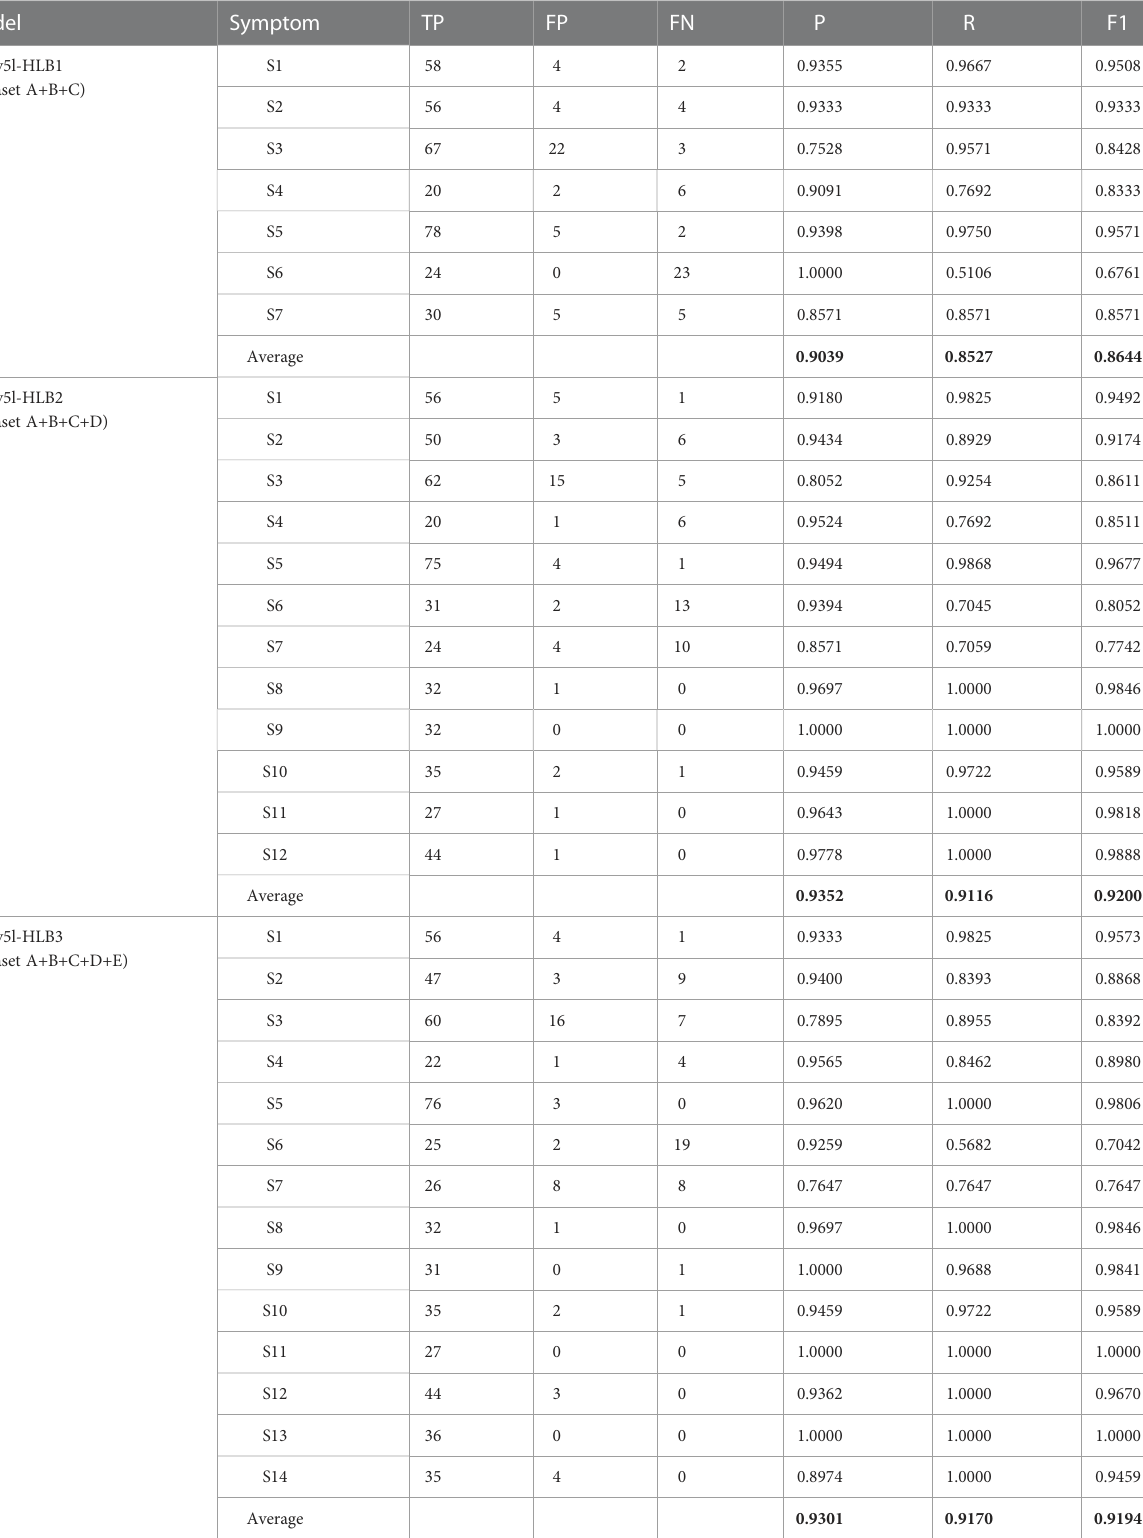
TABLE 3 Detection results of three models using different training datasets.